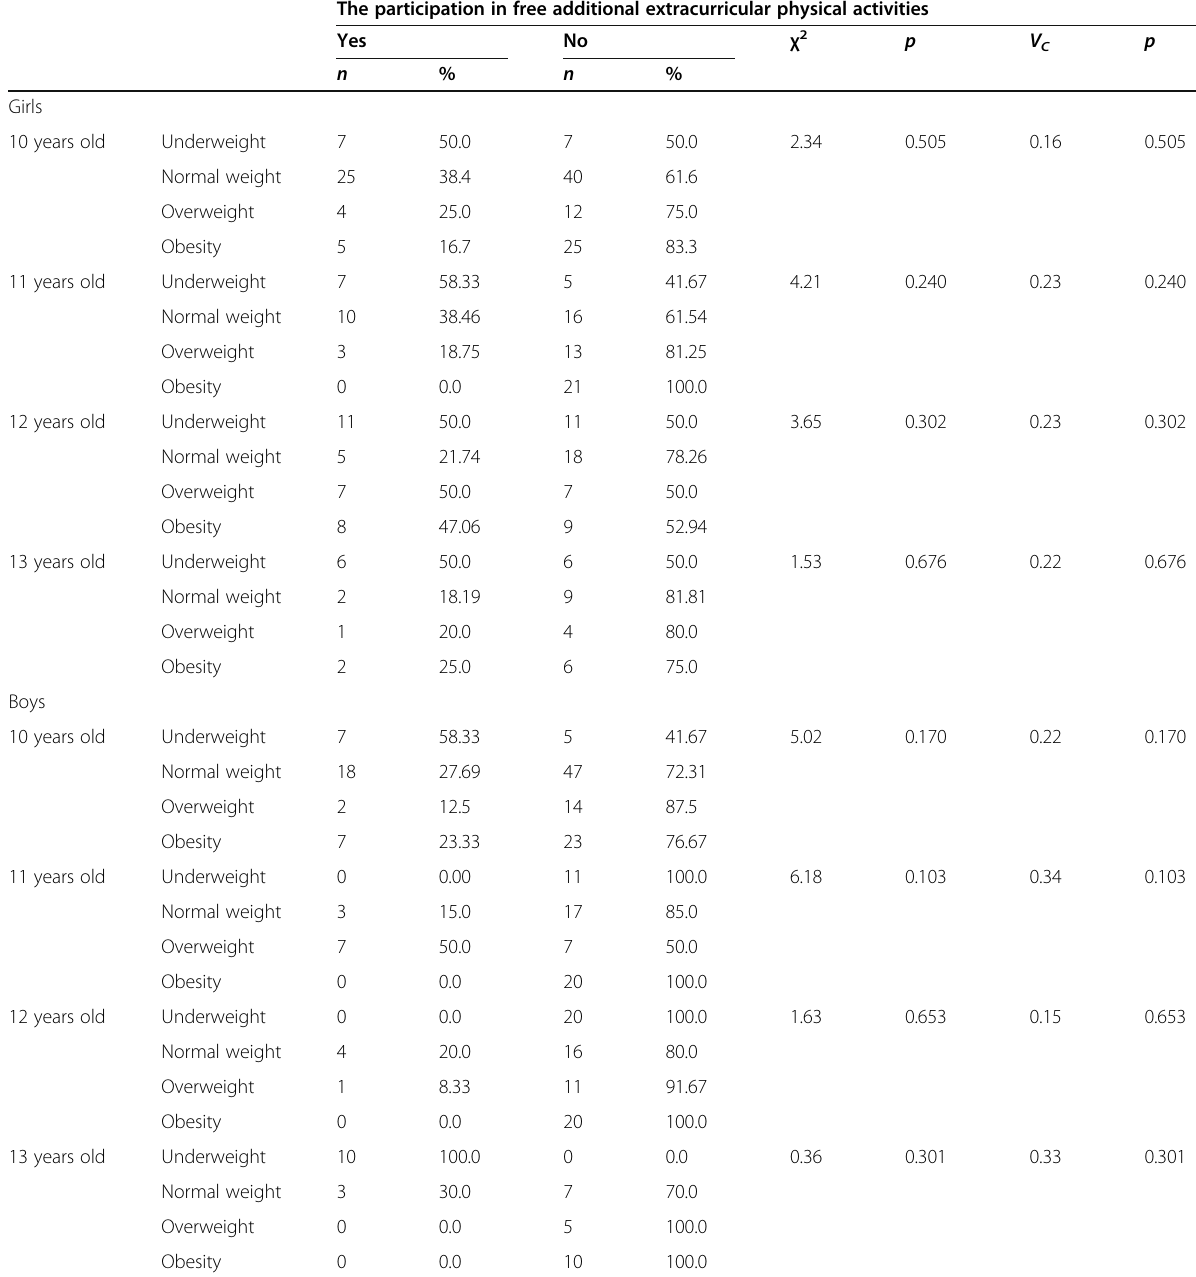
Table 15 The participation in free additional extracurricular physical activities depending on BMI level (underweight, normal weight, overweight, obesity) divided by age and